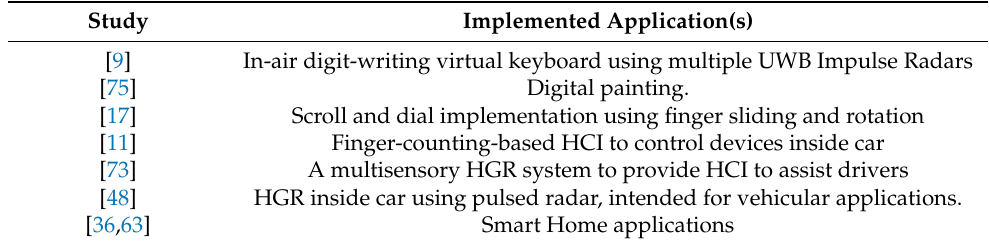
Table 6. Summary of developed applications using Radar